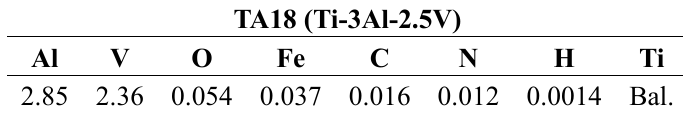
Table 1. Component analysis results of TA18 titanium alloy (mass fraction, %).